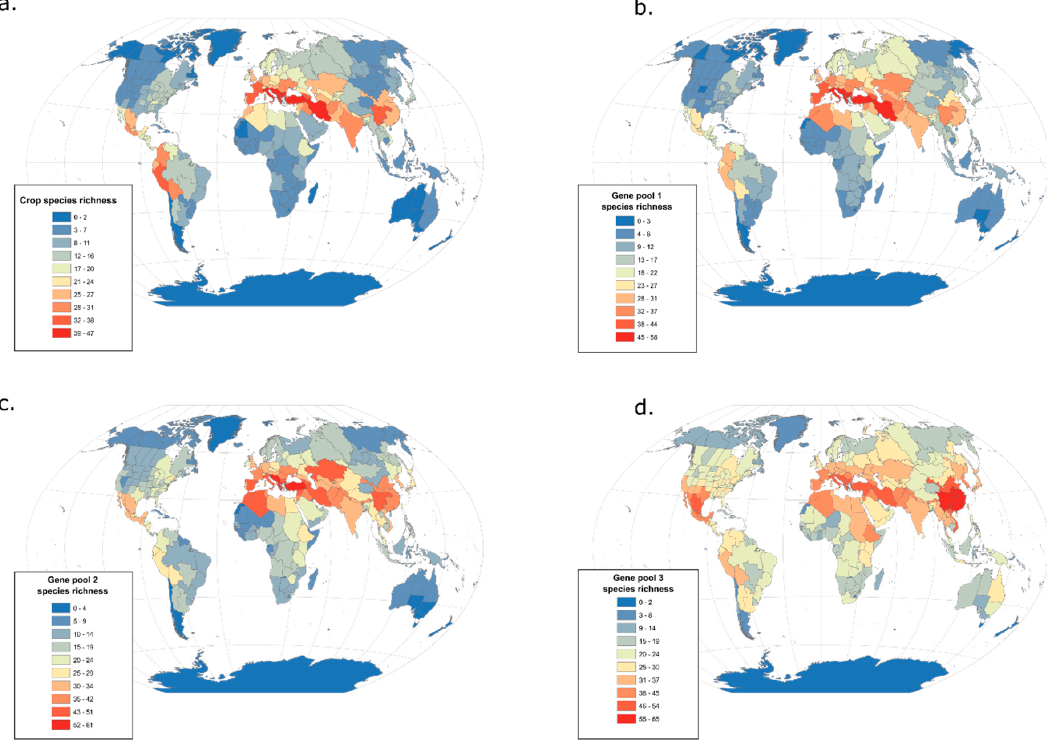
Figure 3. Global distribution of the richness of major crops and their wild relatives. Global distribution of ( a ) 222 major crops, ( b ) 361 wild relative species in gene pool one, ( c ) 1040 wild relative species in gene pool two and ( d ) 2358 wild relative species in gene pool three; see text for gene pool characterisation. Species identities and gene pool classifications were retrieved from the USDA ARS GRIN Global Taxonomy. Distribution data was retrieved from the World Checklist of Vascular Plants at level three of the World Geographical Scheme for Recording Plant Distribution (WGSRPD) [51]. When more than one wild relative species was identified for a crop in a gene pool, we merged their distribution to assign the same weight to each crop and avoid genera with many wild relatives to be